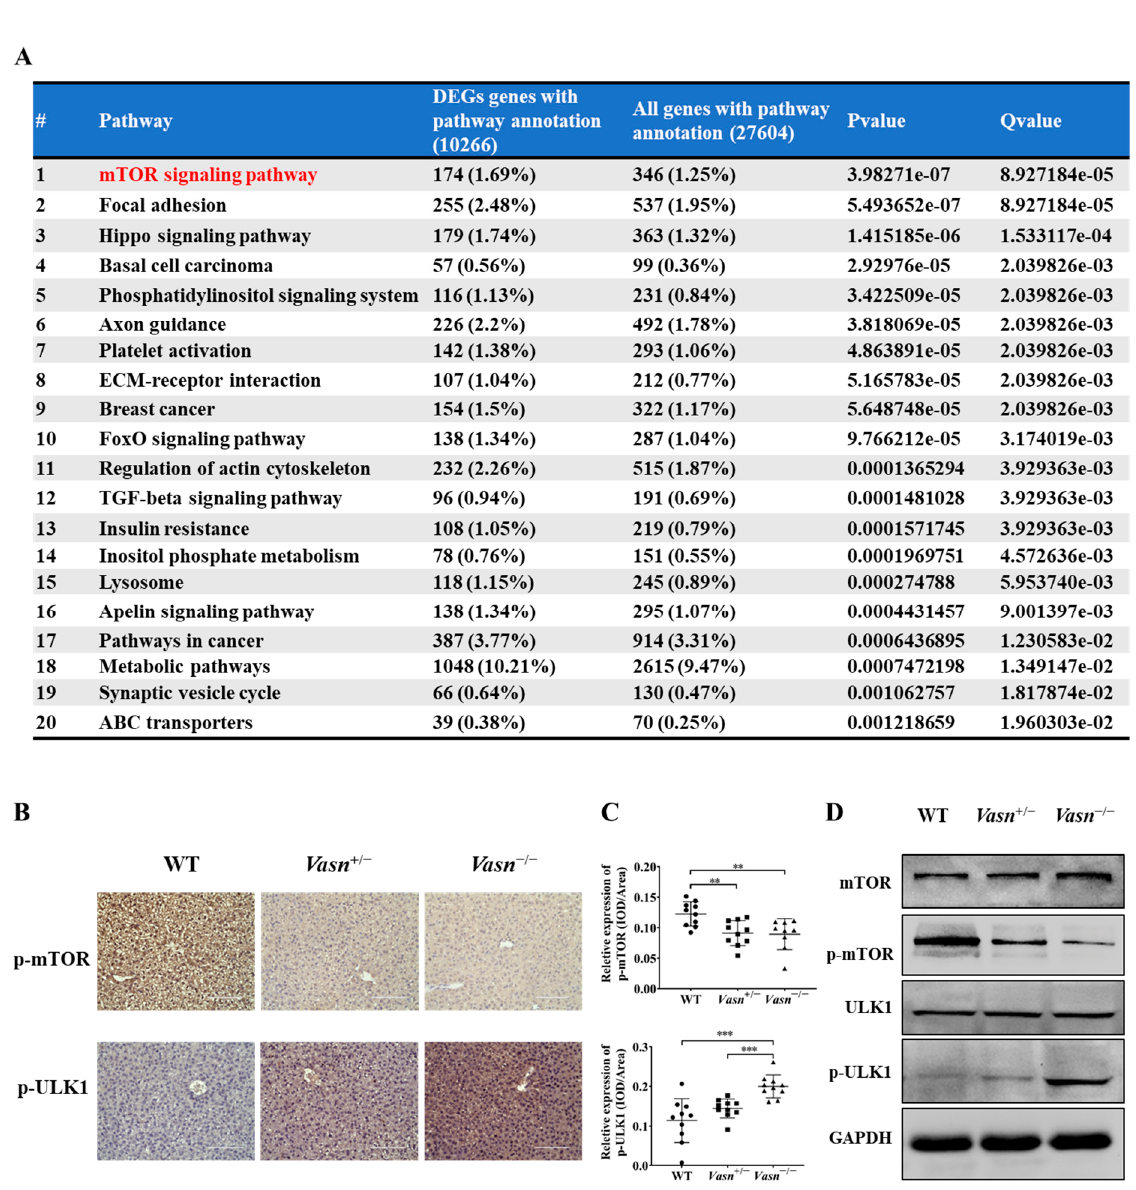
Figure 6. Vasn deletion induced autophagy by regulating the mTOR-ULK1 signaling pathway. ( A ) Pathway enrichment results of target genes of differential expression microRNAs, where the mTOR pathway is of the Top 1 that has been significantly enriched (red highlightened). ( B ) Immunohistochemical analysis of mTOR signaling protein expression in the liver of WT, Vasn +/ − , and Vasn − / − mice; bar = 100 μ m. ( C ) Quantitative integrated optical density (IOD) analysis of immunohistochemical staining from ten mice per group, and three photos per sample. ** p < 0.01, *** p < 0.001. ( D ) Vasn deletion significantly decreased the expression of phosphorylated mTOR (S2448) and increased expression of the phosphorylated ULK1 (S555), confirmed by Western blot analysis.